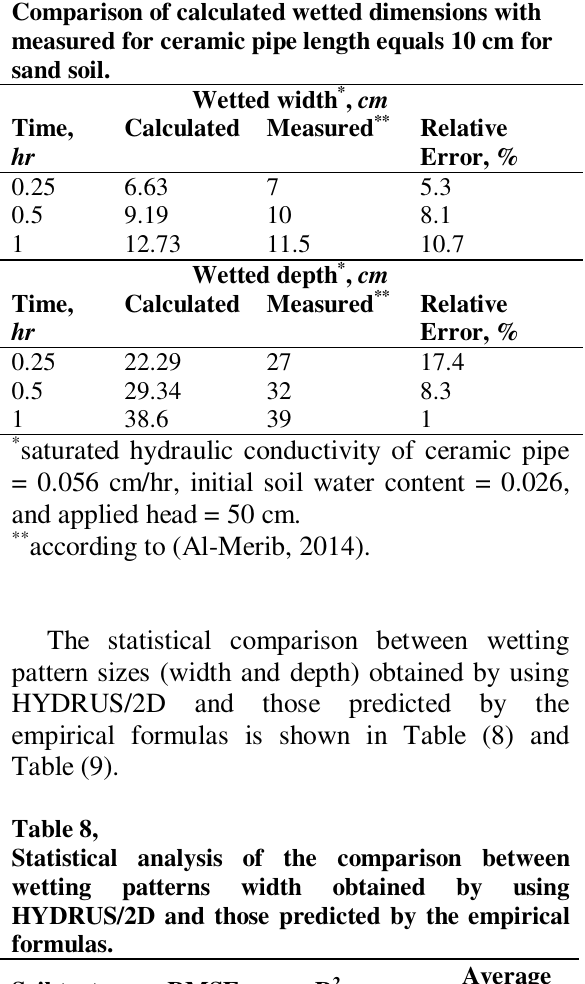
Comparison of calculated wetted dimensions with measured for ceramic pipe length equals 10 cm for sand soil. Wetted width * , cm